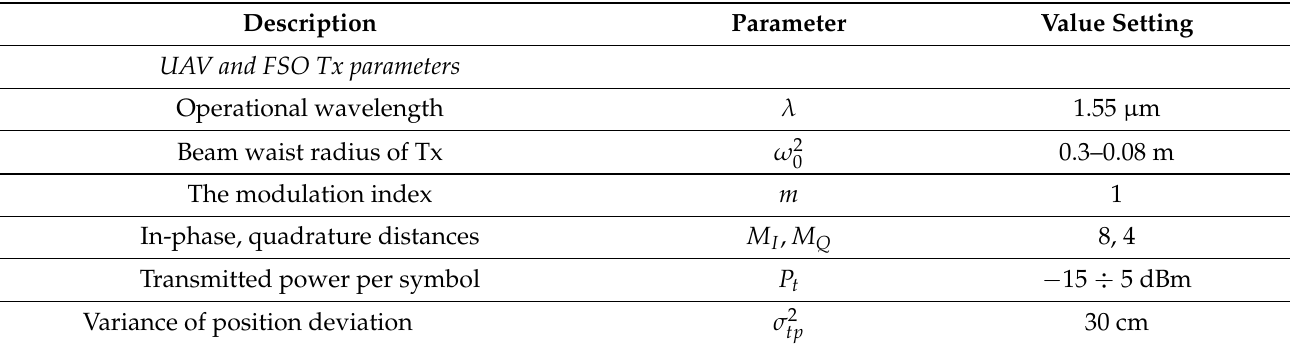
Table 1. UAV/FSO system parameters and